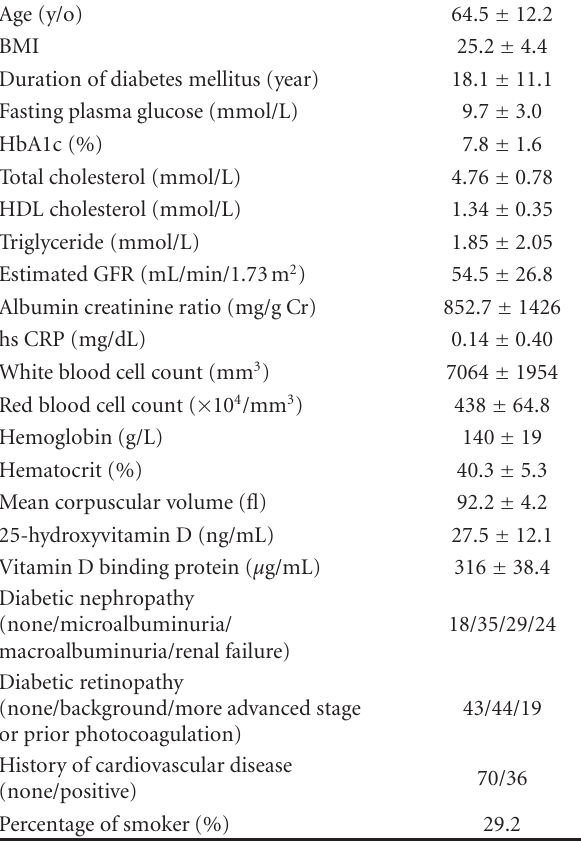
Table 1: Clinical characteristics of subjects. Continuous variables are expressed as mean ± SD.